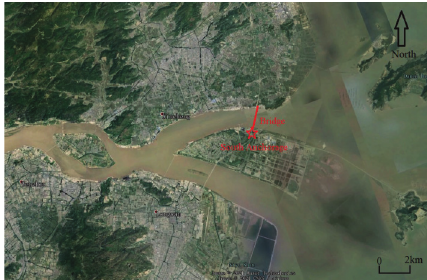
Figure 2: The location of Oujiang River North Estuary Bridge.